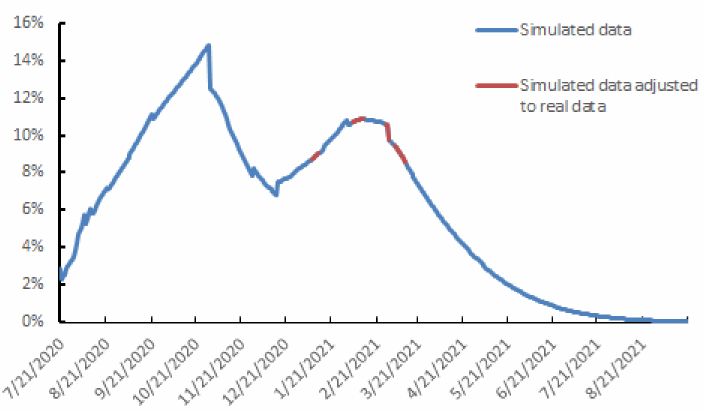
Figure 2. Daily spread of SARS-CoV-2 infection, 21 July 2020 to 5 September